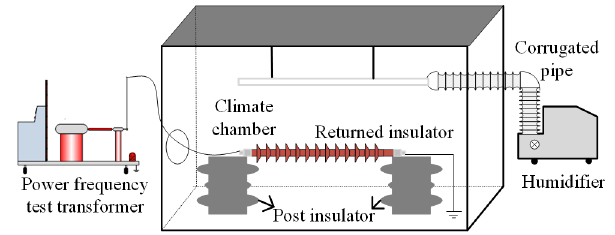
Figure 1. Temperature-rise test platform.